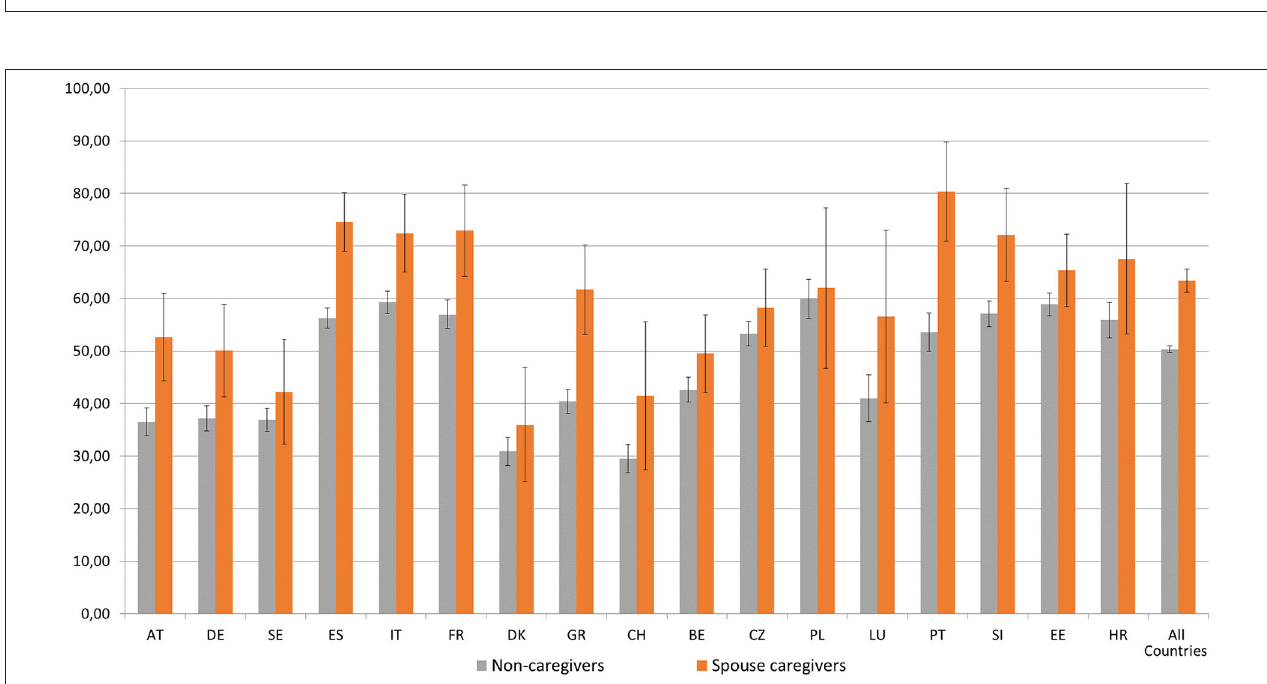
FIGURE 2 | Prevalence of self-reported pain by people aged 65 + by country and caregiver status. Source: SHARE, release 7.0.0., wave 6, weighted data, N = 26,301. Brackets denote 95% confidence intervals. Countries: Austria (AT); Germany (DE); Sweden (SE); Spain (ES); Italy (IT); France (FR); Denmark (DK); Greece (GR); Switzerland (CH); Belgium (BE); Czech Republic (CZ); Poland (PL); Luxembourg (LU); Portugal (PT); Slovenia (SI); Estonia (EE); Croatia (HR).